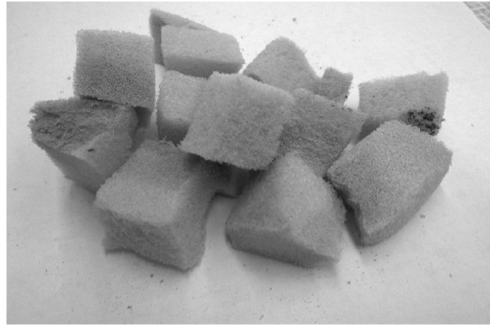
Figure 7. Floating carrier “Polyurethane foam”.